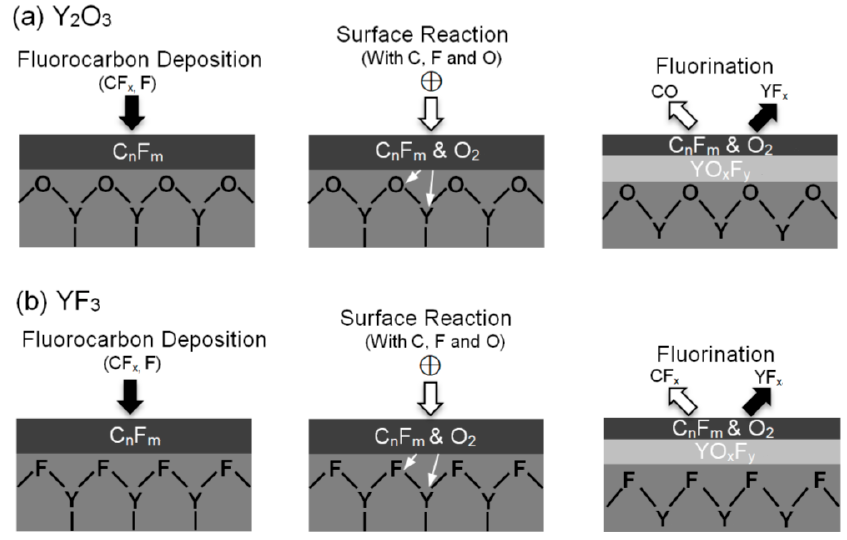
Figure 7. Schematic illustration of yttrium oxyfluoride film deposition behavior on ( a ) Y 2 O 3 and ( b ) YF 3 coatings.